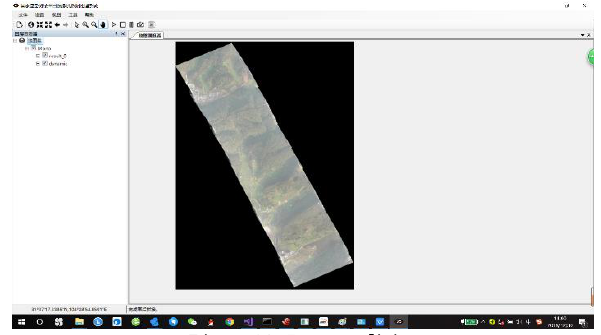
Figure 10. Image splicing